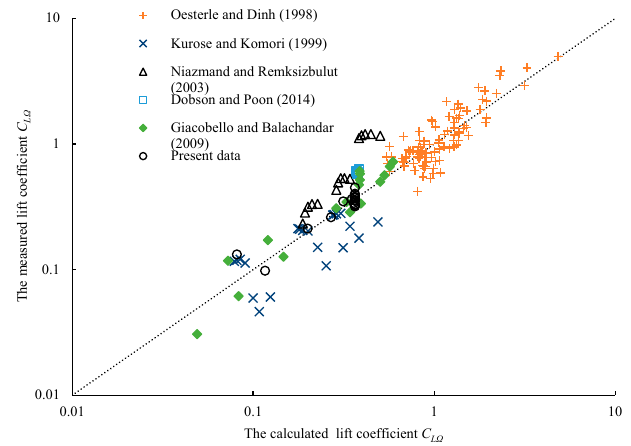
Figure 7. Distribution of the measured lift coefficient against the calculated values [7,13,14,33,34]. Loth [22], Shi and Rzehak [23] proposed expressions to calculate the lift coefficient in flows with a Reynolds number 0 < Re < 1000. It should be noted that the proposed expres- sion in the present study (i.e., Equation (8)) can be applied to calculate the lift coefficient in flows with a Reynolds number up to 3500. In this section, the root mean square relative error ( RMSRE ) is applied as an appropriate index to evaluate the accuracy of different expressions. The RMSRE index can be mathematically expressed in the form below: (cid:3496)𝐶 (cid:3013)(cid:3078)(cid:3030) − 𝐶 (cid:3013)(cid:3078)(cid:3040) (9) 𝑅𝑀𝑆𝑅𝐸 = 𝐶 (cid:3039)(cid:3078)(cid:3040) where C L Ω c and C L Ω m are the calculated and measured lift coefficients, respectively. The RMSRE indices reported by present paper, Loth [22] and Shi and Rzehak [23] are 0.069, 0.073, and 0.121, respectively. When the Reynolds number is in the range of 500 < Re < 3500, the RMSRE indices reported by present paper, Loth [22] and Shi and Rzehak [23] are 0.014, 0.122, and 0.116, respectively. Meanwhile, when the Reynolds number 0 < Re < 500, these indices are 0.081, 0.063, and 0.122, respectively. It is concluded that the proposed expression is reliable and can be applied to estimate the lift coefficient in high- Reynolds flows.